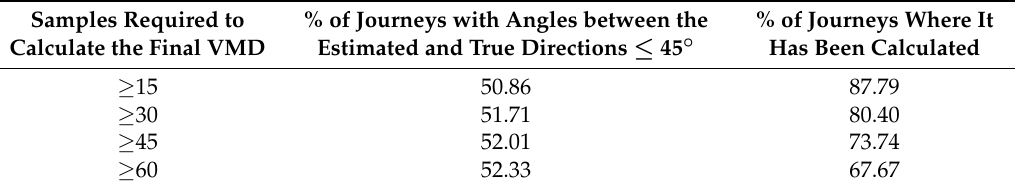
Table 2. VMD results using raw